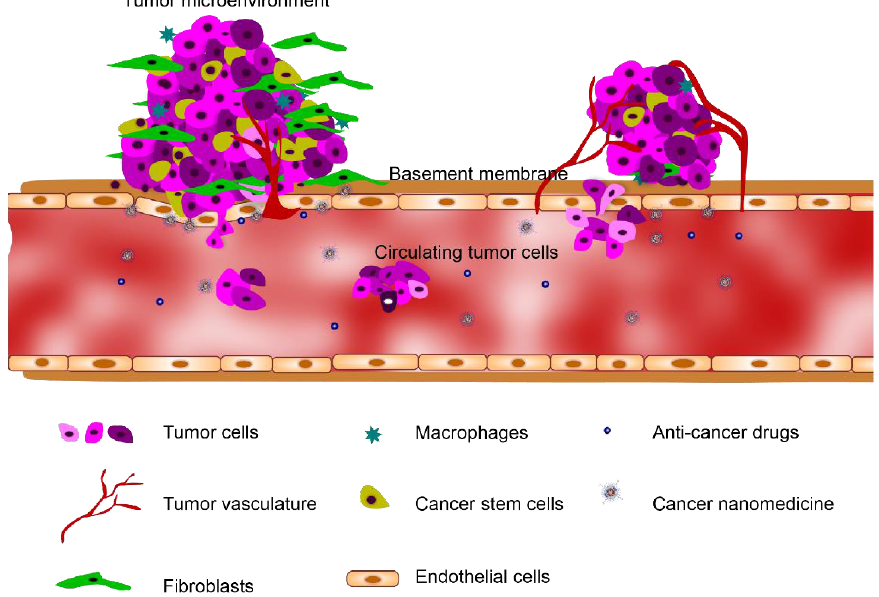
Figure 1. The tumor microenvironment (TME) heterogeneously consists of cellular and non-cellular components including the surrounding blood vessels, immune cells, fibroblasts, cancer stem cells and extracellular matrix (ECM).